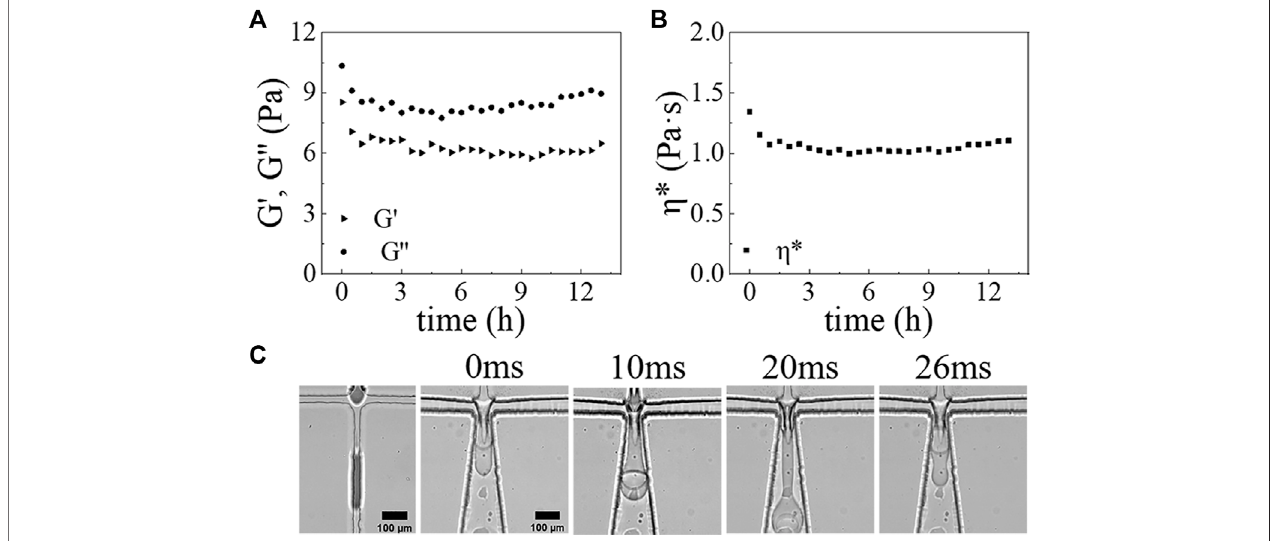
FIGURE 4 | The rheological properties of PDMS mixture versus time at 25 ° C: (A) Storage modulus (G ’ ) (triangular), loss modulus (G ” ) (circular) of PDMS mixture versus time. (B) Complex viscosity ( η *) (square) of PDMS mixture versus time. (C) Optical micrograph images showing the formation process of DE droplets at the fi rst junction and second junction at 0, 10, 20, and 26 ms. Scale bars are 100 μ